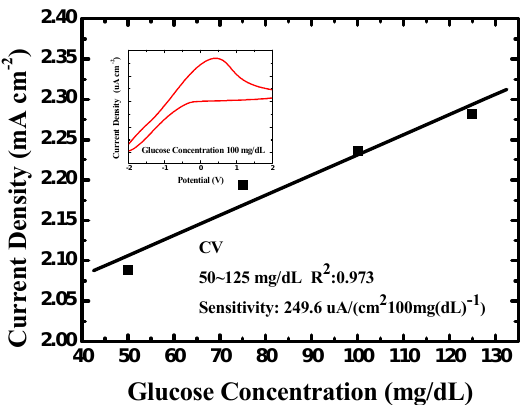
Figure 9. The CV measurement results of the glucose biosensor.